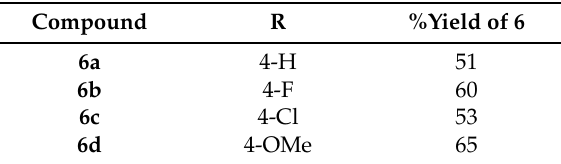
Table 5. Percentage yield of compounds 6a – d .